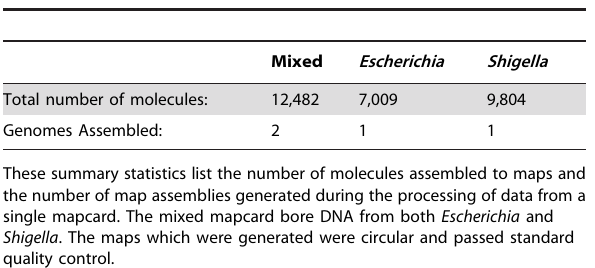
Table 1. Mapping Statistics.